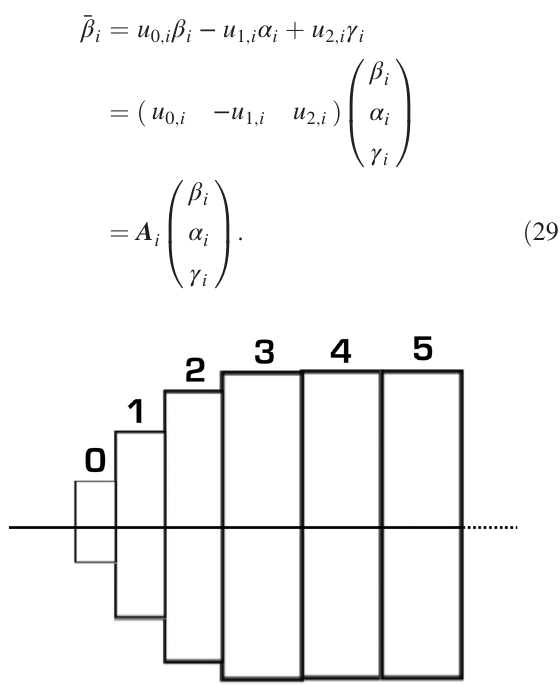
FIG. 4. Illustration of several hard edge quadrupole magnets, together modeling a quadrupole with varying field. The slices are numbered, β 0 , α 0 , and γ 0 corresponds to the beta function at the entrance of slice